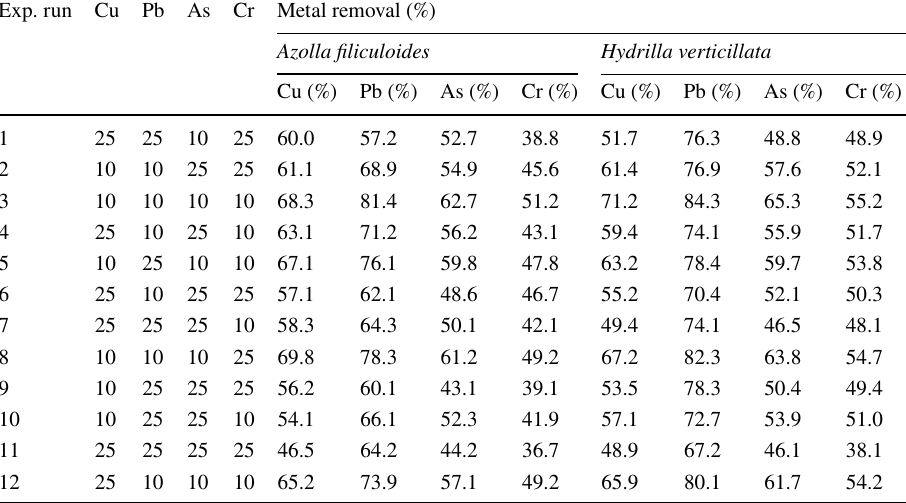
Table 1 Plackett–Burman experimental design matrix showing different combination levels of the heavy metals in the study along with the removal of metals by Azolla filiculoides and Hydrilla